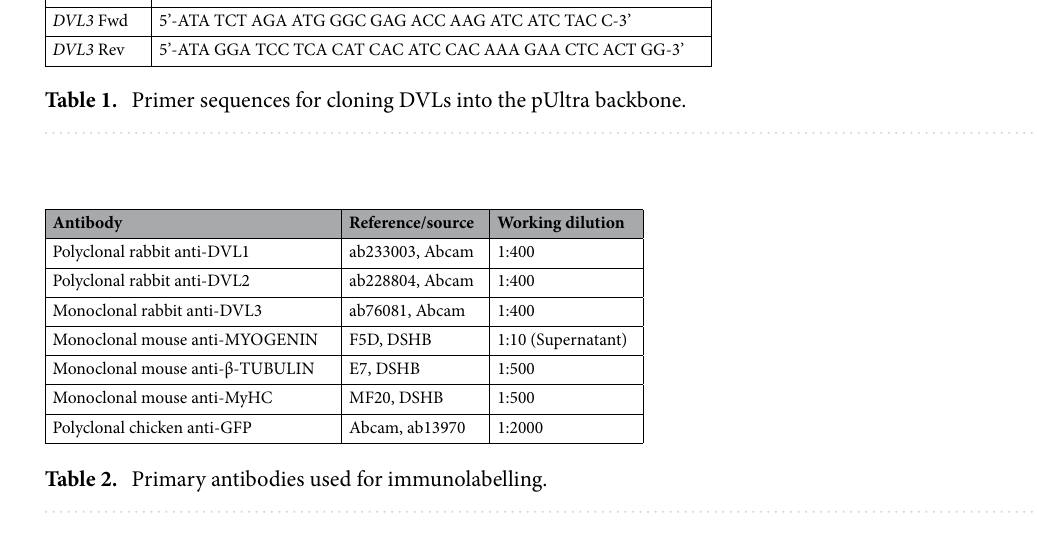
Cell size and circularity calculation. Proliferating cells were fixed and immunolabelled for β-TUBULIN. Shape and circularity were calculated using Fiji 66 by drawing around individual cells and measuring the param- eters. Circularity is represented as a value ranging from 0 to 1, where 0 is a straight line and 1 is a perfect circle. SiRNA mediated knockdown. 80 000 cells were transfected with 1.5 nM siRNA (final concentration) against DVL1 (Qiagen, SI02633183, mix of 4 different siRNA), DVL2 (Qiagen, SI00063448, mix of 4 different siRNA), DVL3 (Qiagen, SI00063476, mix of 4 different siRNA) or scrambled control siRNA for 24 h. 1.5 nM